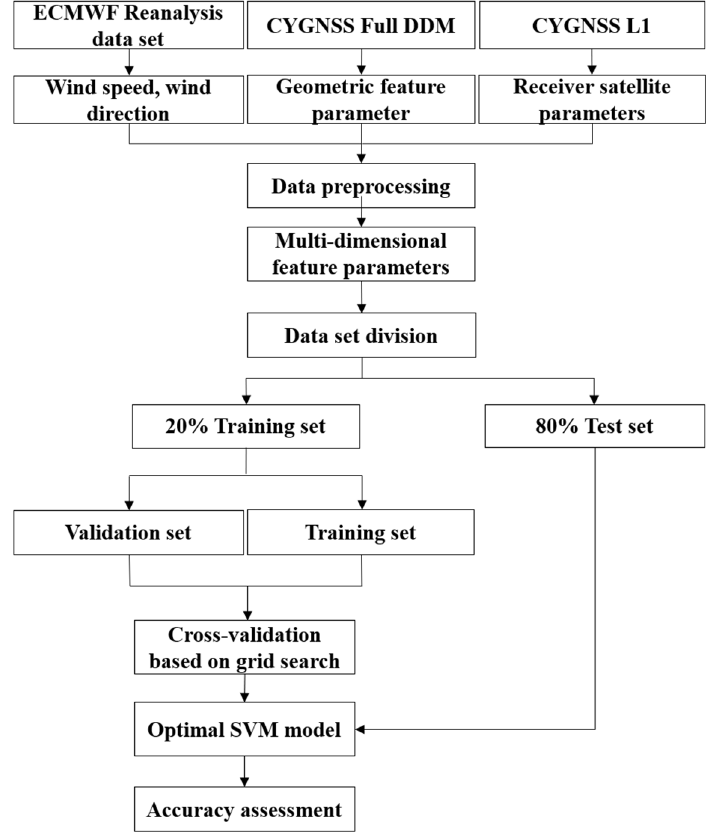
Figure 6. GNSS-R wind direction retrieval flow chart based on SVM.